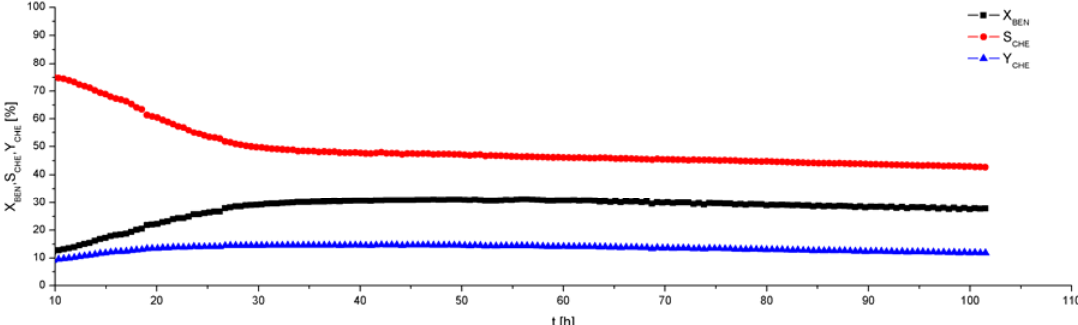
Figure 8. Cyclohexene selectivity and yield against the conversion of benzene under optimized conditions. (Reaction conditions: 3 g 2Ru/La 2 O 3 –ZnO, 8 mg NaDCA, 20 bar H 2 , V water / V benzene = 2/1, 800 rpm, 150 °C). Table 3. Grain size and ICP-OES measurements of the supporting material and catalyst before and